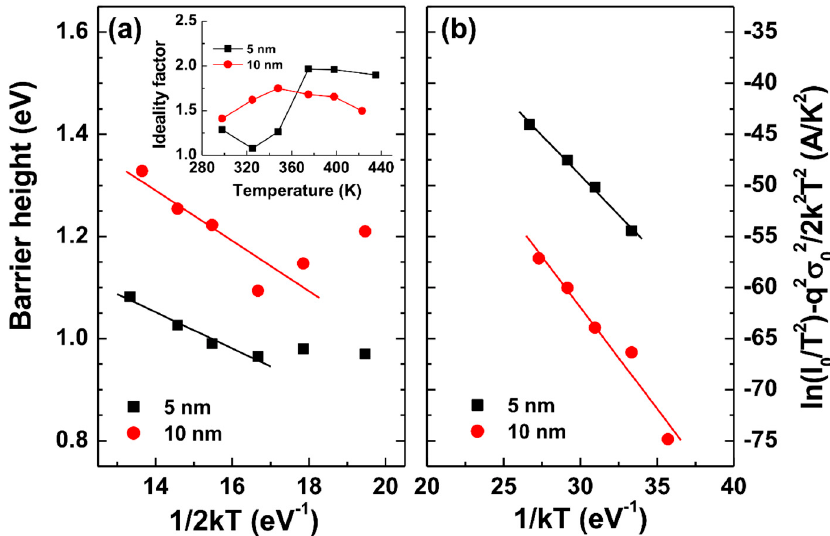
Figure 2. Current–voltage ( I – V ) data obtained at various temperatures: ( a ) 5 nm and ( b ) 10 nm thick AlGaN samples. The inset in ( a ) shows the reverse leakage current densities at − 10 V.